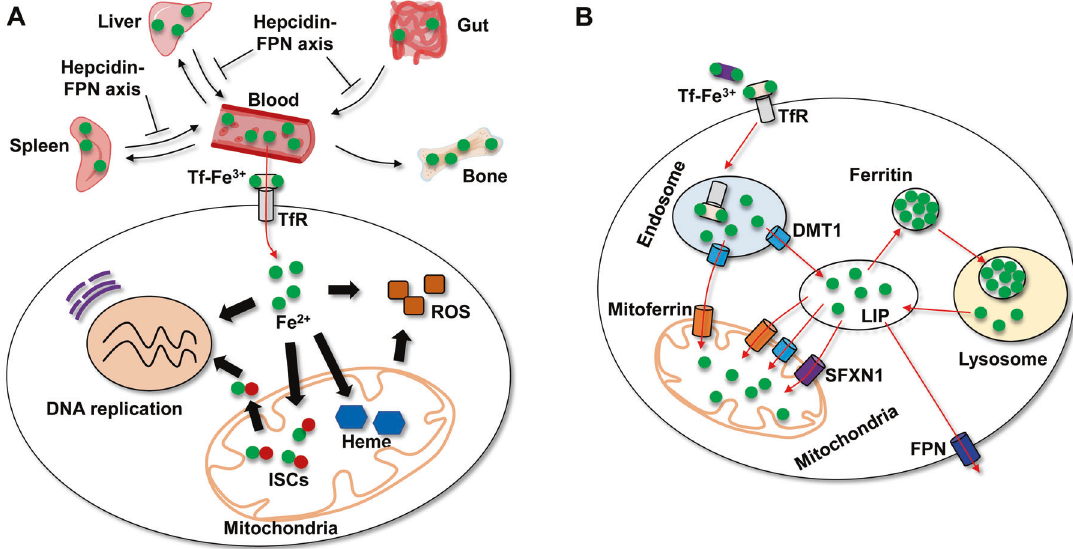
Fig. 1 Systemic iron metabolism and iron-mediated physiological functions. A Systemic iron metabolism is regulated by the hepcidin-FPN axis. After the uptake of dietary iron in the gut, iron binds to circulating Tf and is transferred to organs throughout the body, particularly to the bone marrow for hemoglobin synthesis and RBC production. Liver-secreted hepcidin serves as a master regulator of systemic iron homeostasis through inducing degradation of FPN, a protein that is ubiquitously expressed and is currently the only known mammalian iron exporter. Kupffer cells in the liver and macrophages in the spleen phagocytize the damaged or aged red blood cells and recycle their iron. Iron is taken up by cells via the Tf/TfR1 pathway and used for multiple functions including heme and ISC synthesis in mitochondria, and DNA replication. ISCs are important for mitochondrial functions and DNA replication. However, excess iron can also generate ROS. B Iron uptake, redistribution, and export at the cellular level. Endocytosis of Tf-TfR1 complex releases iron to the cytosol LIP by DMT1 or directly to mitochondria via DMT1 and mitoferrin. Iron from LIP can be transported to mitochondria by DMT1, mitoferrin, and SFXN1, exported by FPN, or stored in ferritin. After degradation of ferritin in the lysosomes, iron is released to replenish